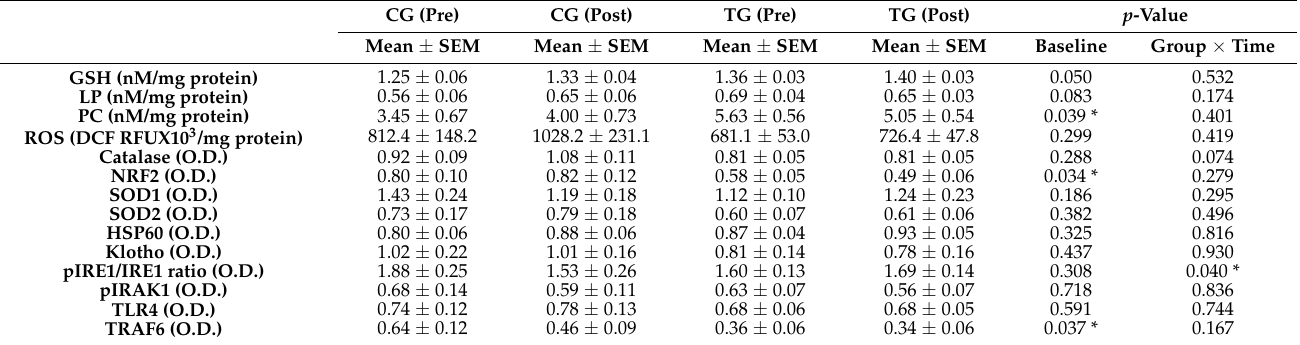
CG = control group; O.D. = optical density; TG = training group. The * indicates a significant differ- ence either at baseline or following training between CG and TG.